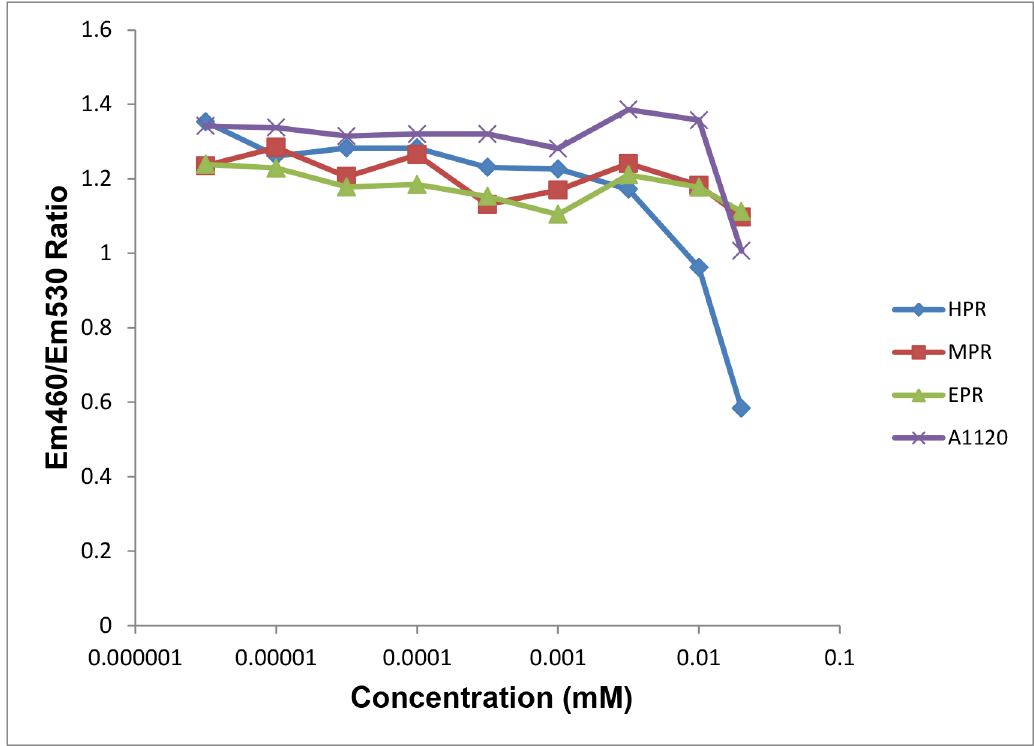
Fig 4. Phenylretinamides and A1120 do not compete or compete poorly with 1 nM at-RA in RARbetaantagonist assay. Fenretinide is the only tested compoundthat appearsto compete, exhibiting an IC 50 = 10 μ M. Fluorescence was measuredat excitation(ex) 409 nm/emission (em) 460 and at ex 409nm/em530 nm and the ratio was determined and plotted againsta range of concentrations (10 − 5 to 10 − 9 M) of the tested compounds.